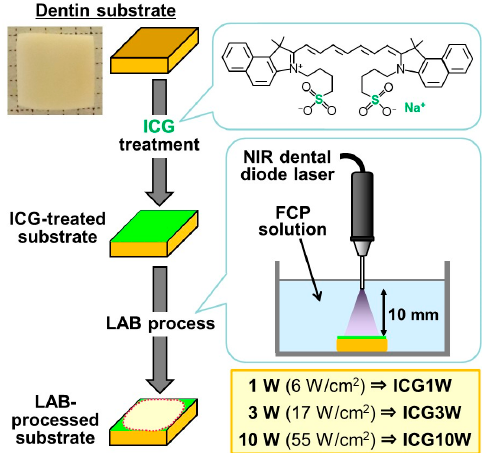
Figure 1. Digital camera image of an untreated human dentin substrate (top-left, grid = 1 mm) and schematic of the refined LAB process: NIR dental diode laser irradiation at various powers for 3 min of the dentin substrate in an FCP solution following ICG treatment.